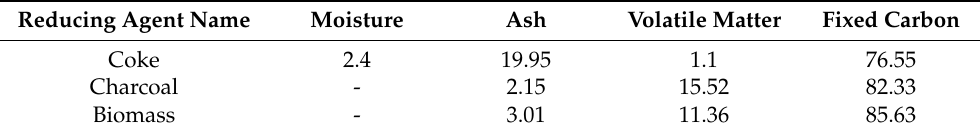
Table 2. Proximate analysis of reducing agent (mass percent,